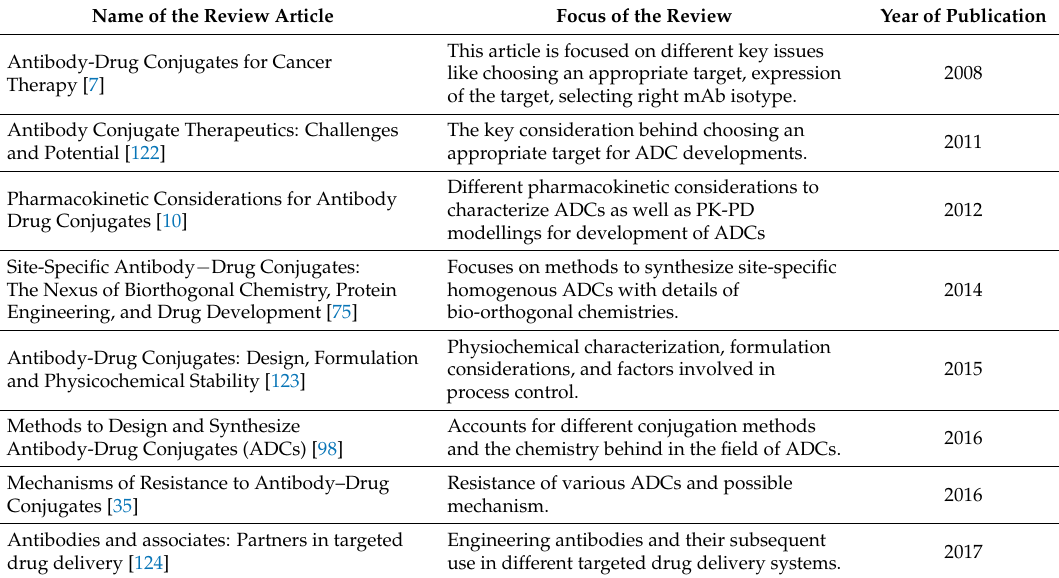
Figure 6. Schematic diagram showing transition of ADCs from laboratory to clinic. Table 3. List of some of the key review articles on